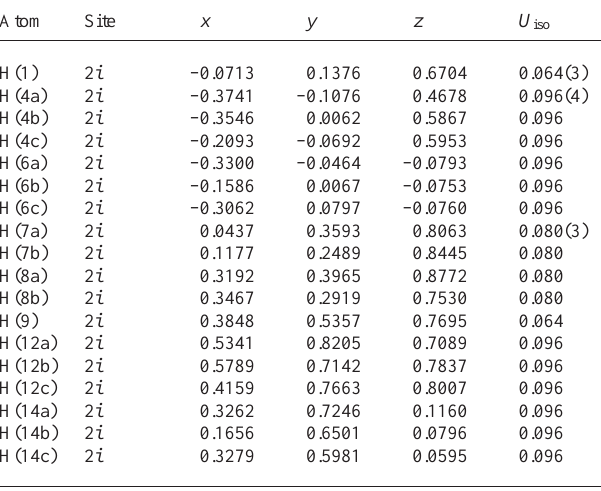
Table 2. Atomic coordinates and displacement parameters (in Å 2 )